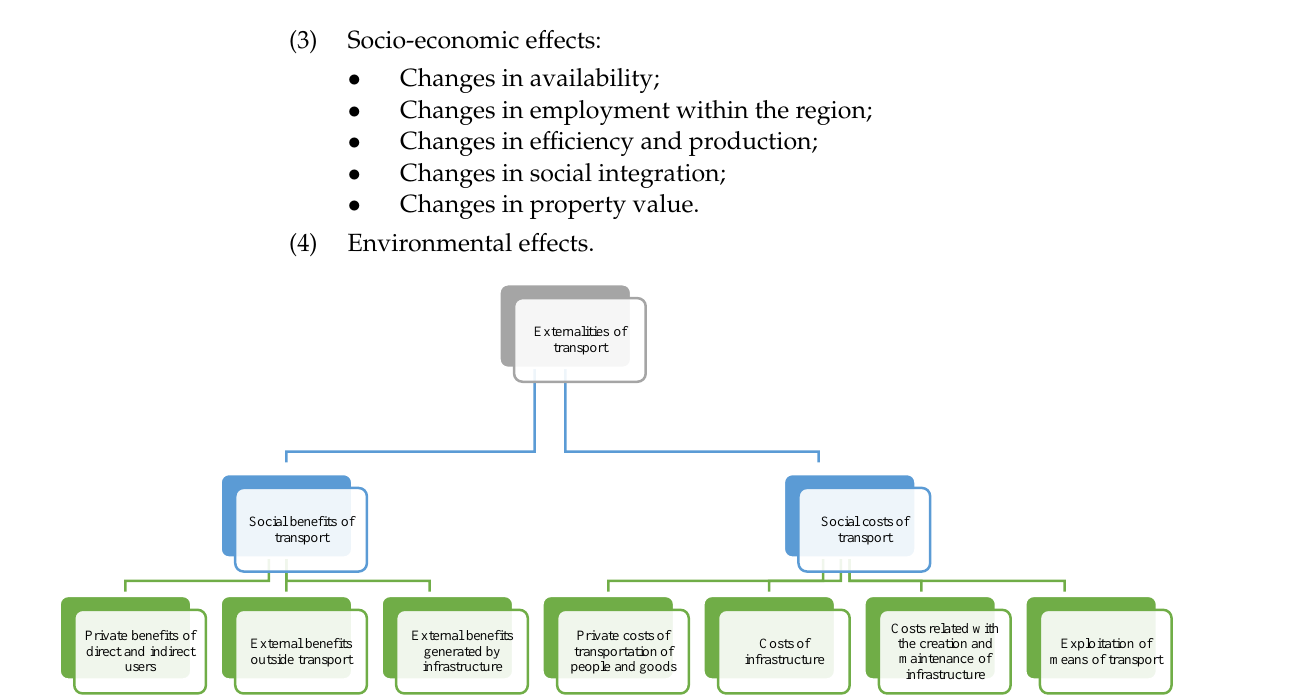
Figure 1. Externalities of transport according to T. Kami´nska. Source: own study based on